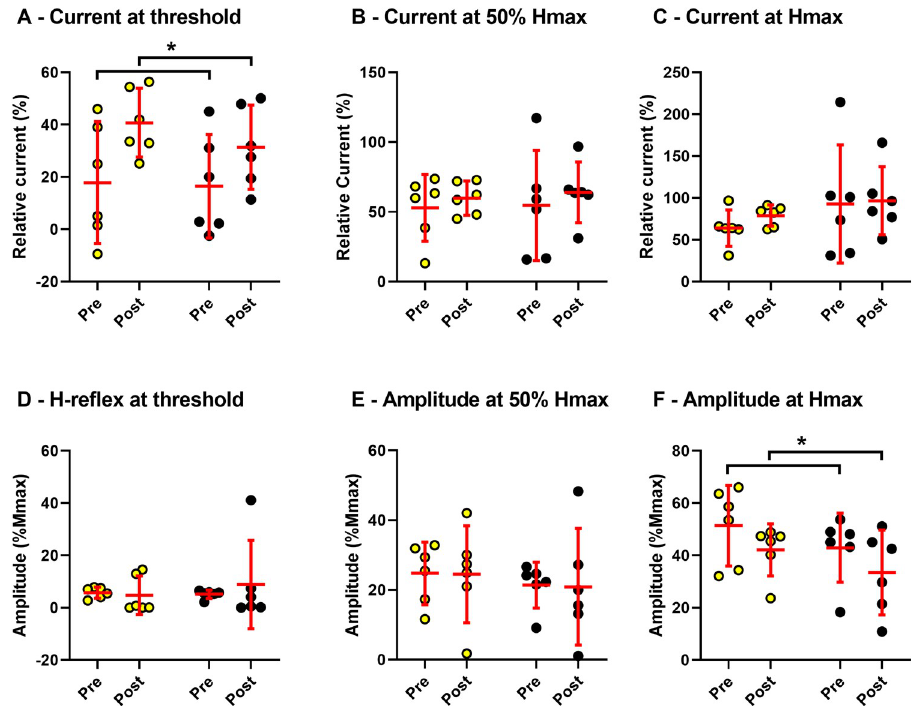
Fig 3. Individual and group (n = 6) mean ( ± 95% CI) values are shown with individual points and red bars. In all panels, the untrained limb is represented with yellow fill, whereas the trained limb is represented with black fill. A-C: the current required to evoke: H-reflex threshold; 50% Hmax; and, Hmax. D-F: the amplitudes of H-reflexes at the current from pre to evoke: threshold; 50% Hmax; and, Hmax. Detailed descriptions of all variables can be found in Klimstra and Zehr [2008]. Asterisks indicate significant main effects of time.